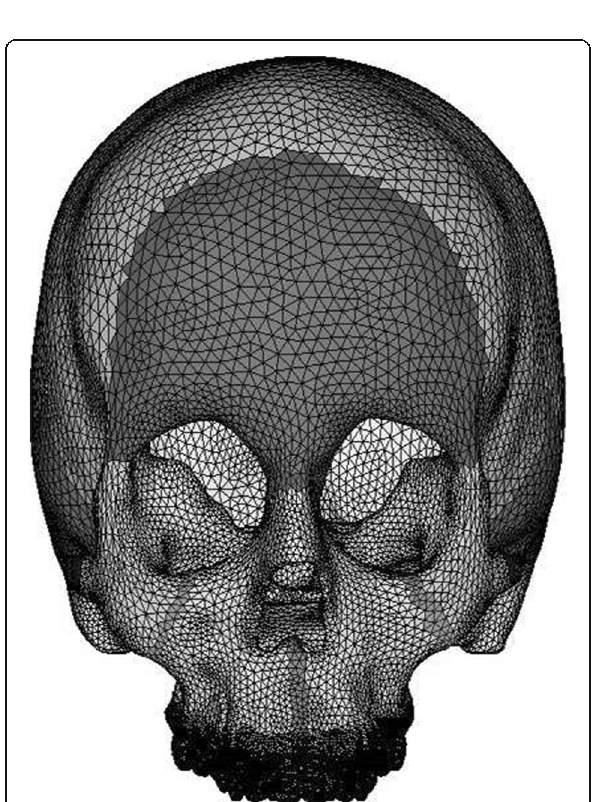
Fig. 2 Frontal view of the three-dimensional FE model